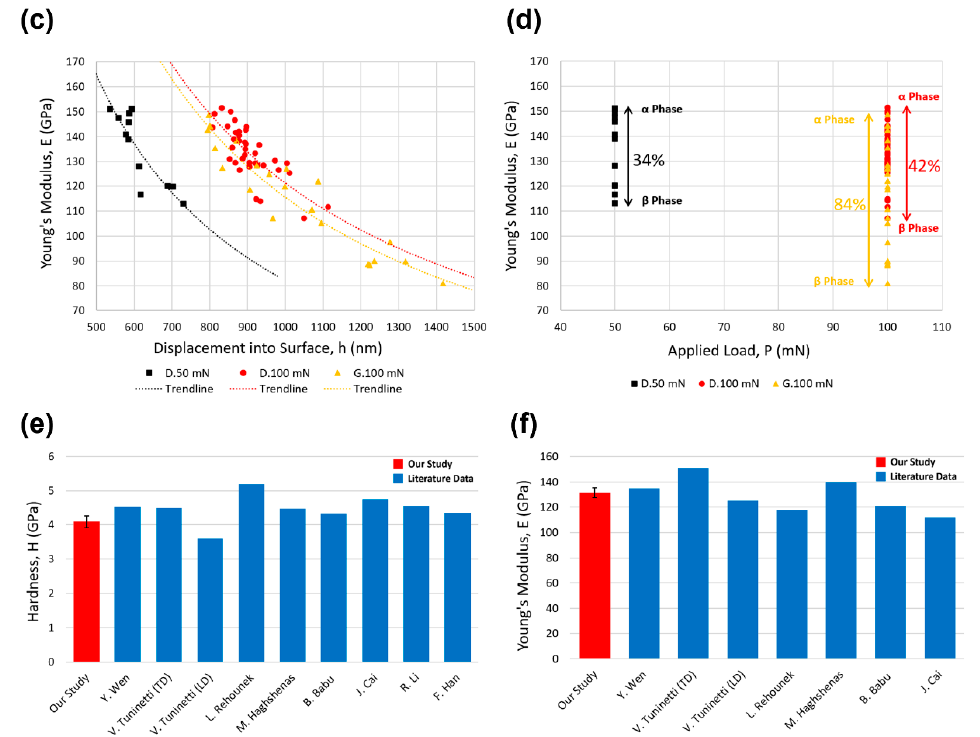
Figure 12. Measured hardness with respect to ( a ) displacement into the surface and ( b ) applied load. Measured Young’s modulus with respect to ( c ) displacement into the surface and ( d ) applied load. Comparison of measured ( e ) hardness and ( f ) Young’s modulus with the literature. The error bars denote ±2 standard errors, displaying an approximate 95% confidence interval for our estimate.